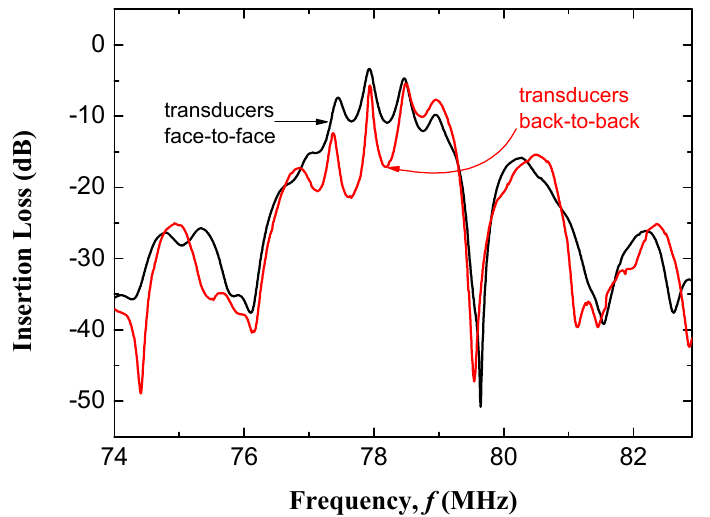
Figure 10. Frequency responses of the test devices with traditional EWC-SPUDT cells. The elements of P-matrix are related to the scattering coefficient, therefore, the direc- tivity D in logarithmic form can also be approximately expressed as − 20 log The frequency dependence of D for an optimized EWC-SPUDT compared with that for a traditional EWC-SPUDT is shown in Figure 11. The maximum directivity of transducer based on the optimized EWC-SPUDT cells reaches 30.1 dB, which is much larger than that based on the traditional EWC-SPUDT cell. It suggests that the optimized EWC-SPUDT cell can be used to achieve miniaturization and higher performance in SAW device